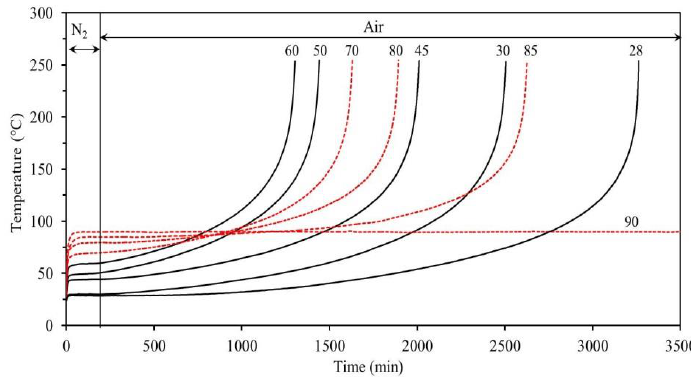
Figure 13. SIT curves for fishmeal in the room-temperature to 100 °C range.